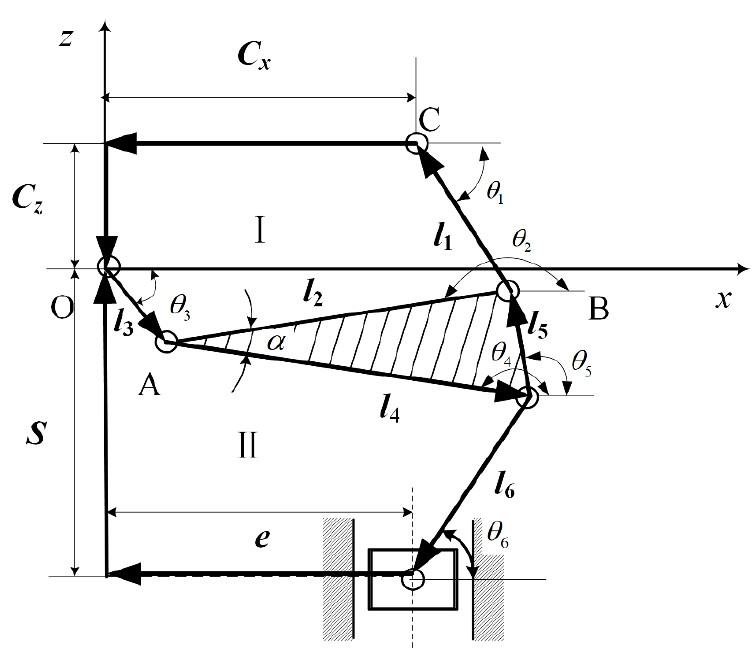
Figure 4. Vector diagram of mechanism.